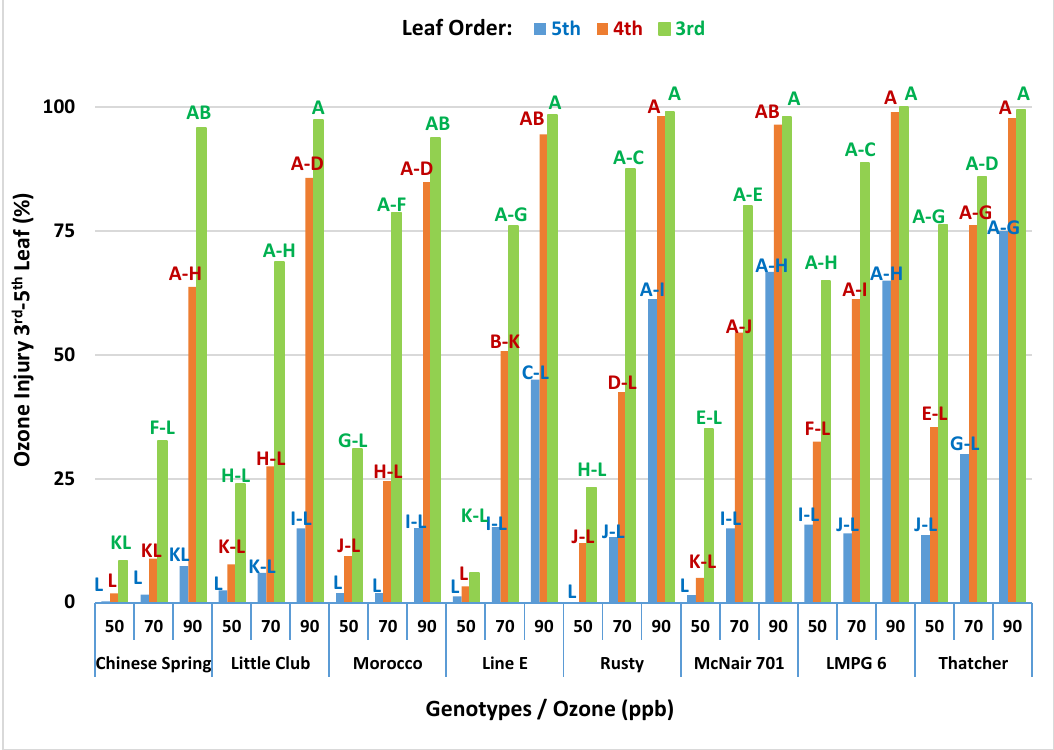
Figure 10. O 3 injury on the third–fifth leaf of rust near-universal susceptible genotypes, at three different O 3 levels, exposed for 14 days (12 h/day), at 25 °C and 50% RH, in OPECs. Injury was visually estimated, under constant light conditions according to a 0–100% scale. Means were statistically separated using Tukey-Kramer adjustment for multiple comparisons. Means marked with the same letter are not significantly different at α = 0.05.